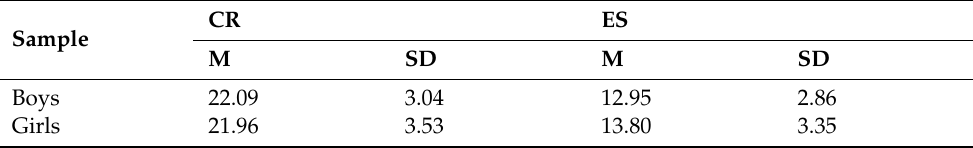
Table 4. Mean (M) and standard deviation (SD) of CR and ES in boys and girls. Sample